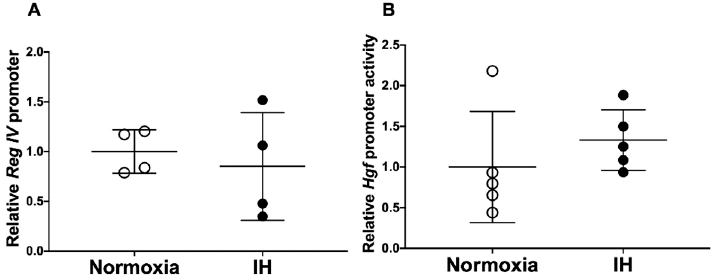
Figure 7. Luciferase assays of promoter activities of ( A ) Reg IV and ( B ) Hgf in P19.CL6 cells. Reporter plasmids, prepared by inserting the promoter fragments of mouse Reg IV ( − 2008–+29) upstream of a firefly luciferase reporter gene in pGL4.17 vector and rat Hgf ( − 1336–+59) in pGL3-Basic vector [36], were transfected into P19.CL6 cells. After the cells were exposed to either IH or normoxia for 24 h, the cells were lysed, and the promoter activities of Reg IV and Hgf were measured. The promoter activity was normalized for variations in transfection efficiency using β -galactosidase activity as an internal standard. The promoter activities exposed to normoxia were set to 1.0. All data are represented as the mean ± SD of the samples. The statistical analyses were performed using Student’s t -test.